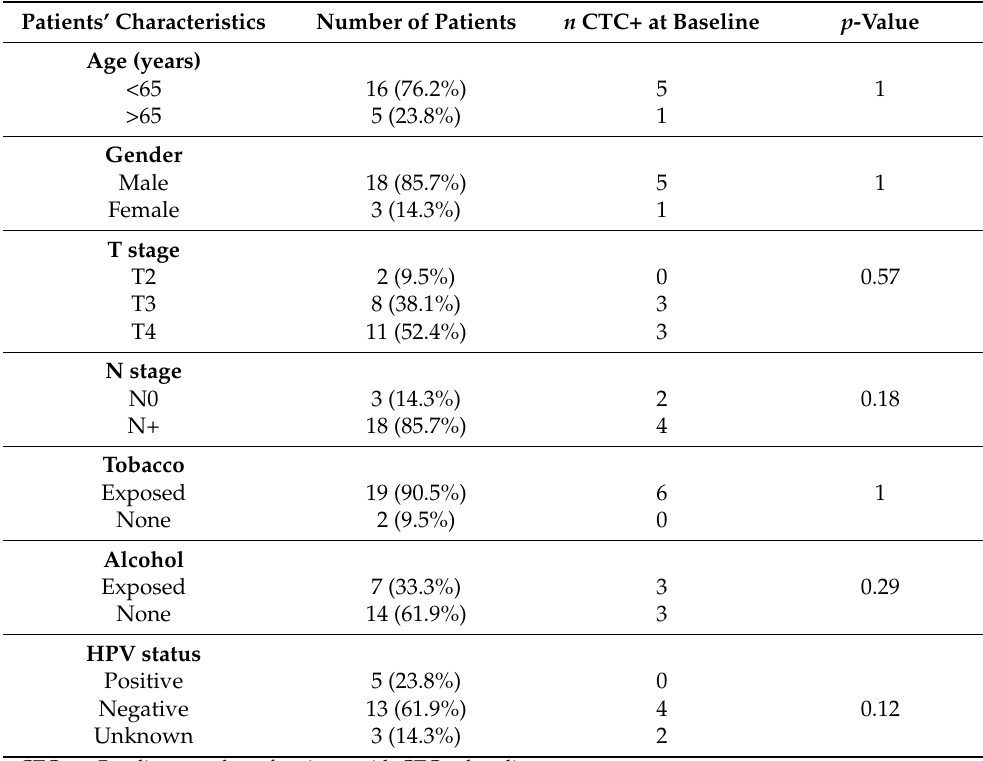
Table 1. Patients’